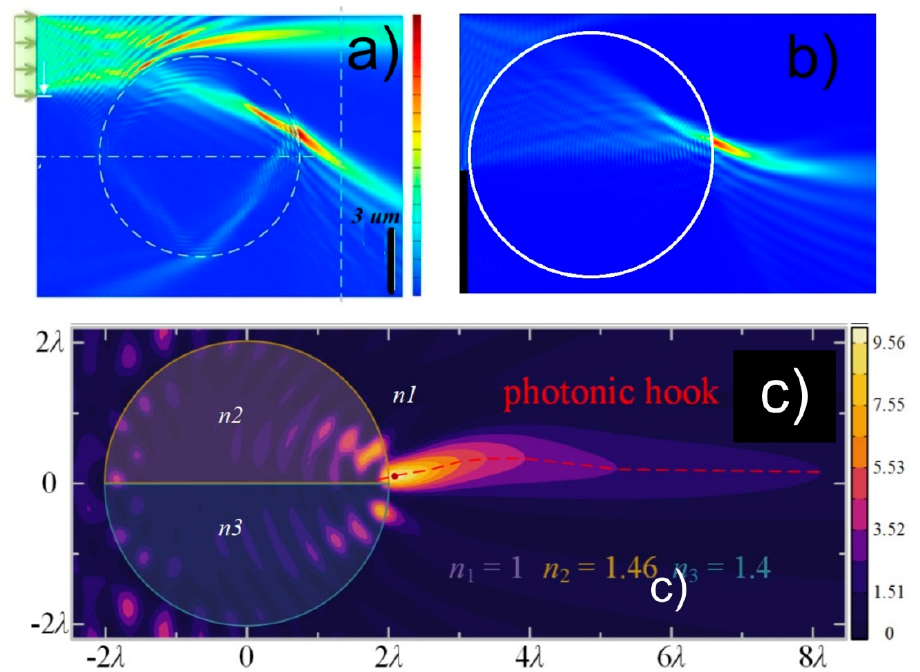
Figure 4. Photonic hook based on Janus particle: ( a ) cylinder with off-axis Gaussian beam [51], ( b ) cylinder with partially broken wavefront [52], ( c ) cylinder with two materials [56].